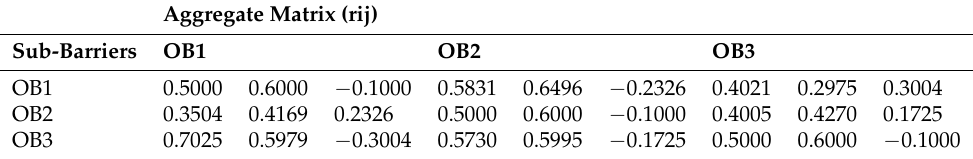
Table A8. The aggregated IF judgment matrix.